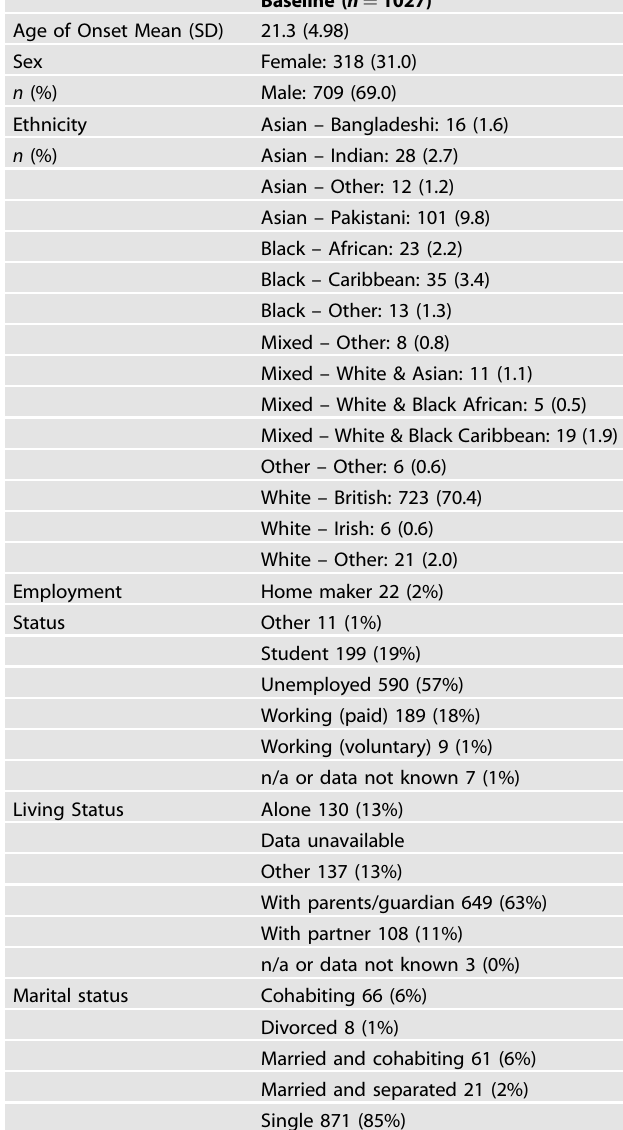
Table 1. EDEN Sample Characteristics at